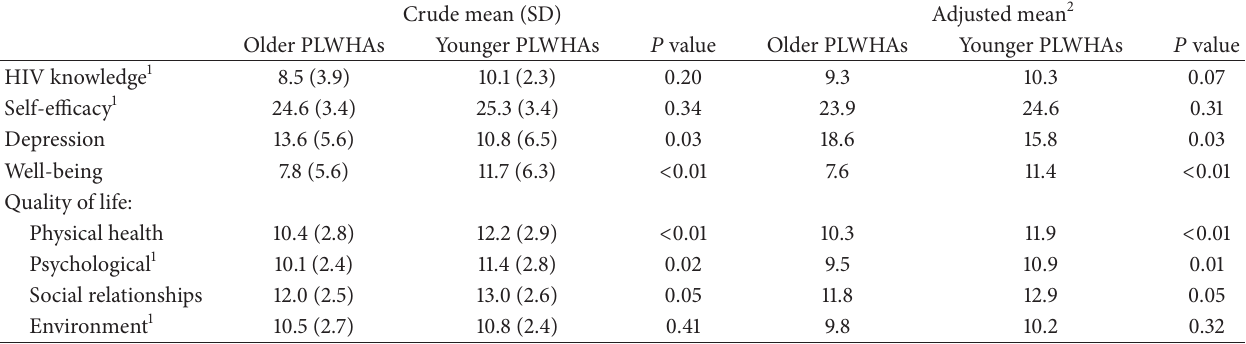
Table 2: Distributions of HIV knowledge, self-efficacy, well-being, depression and quality of life.